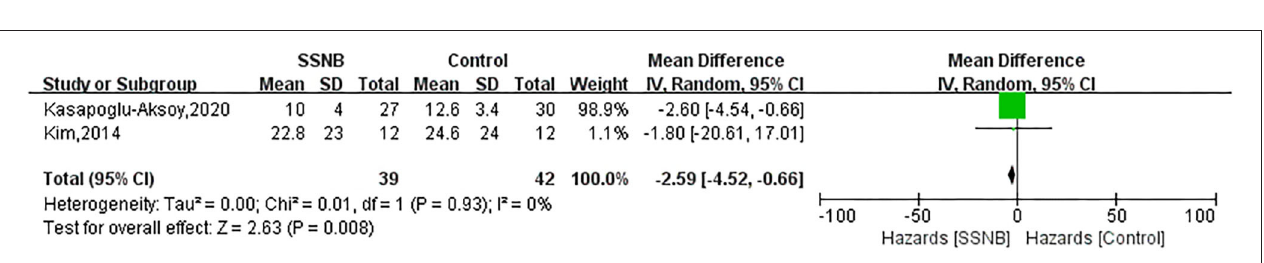
FIGURE 6 | Forest plot of FMA between SSNB and other